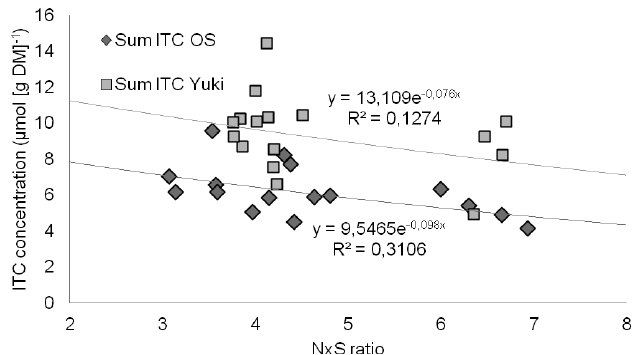
Fig. 6: Influence of different the cvs. Yuki (Y) and Orient Surprise (OS) and the N×S ratio on the ITC concentration in Chinese cabbage.